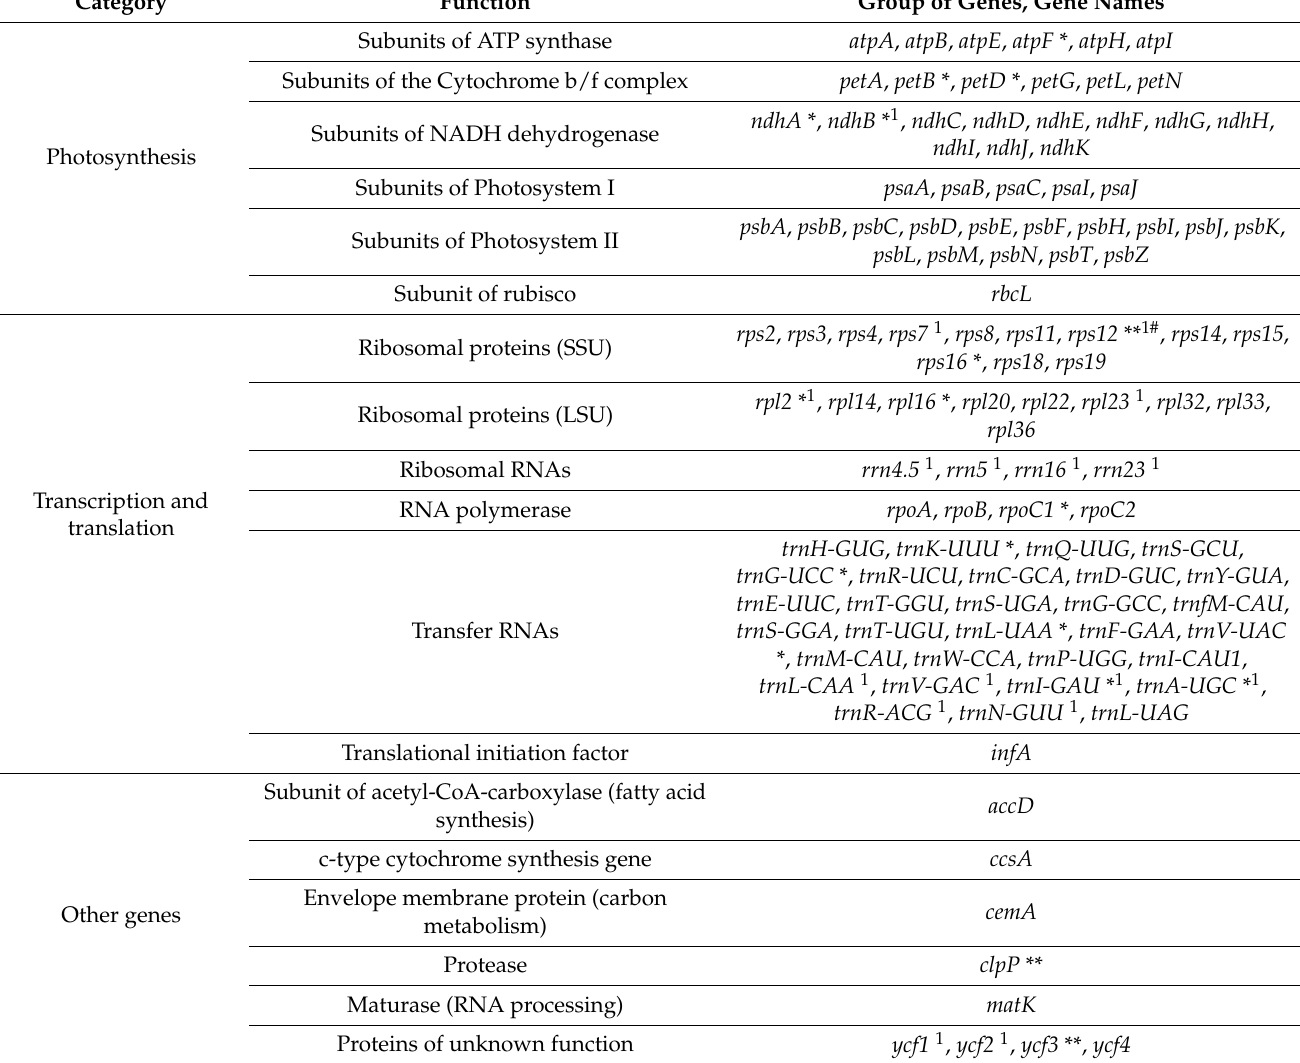
Table 1. Genes annotated in the D. oligodontus chloroplast